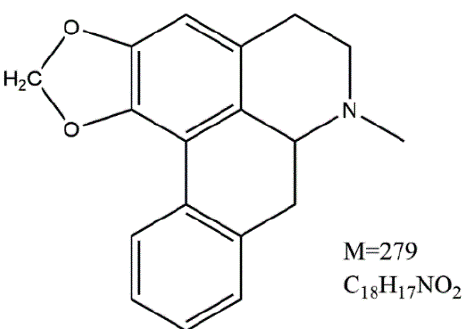
Figure 1. Chemical structure of RM, which is an aporphine alkaloid isolated from the fresh rattan stem of Fibraurea recisa .